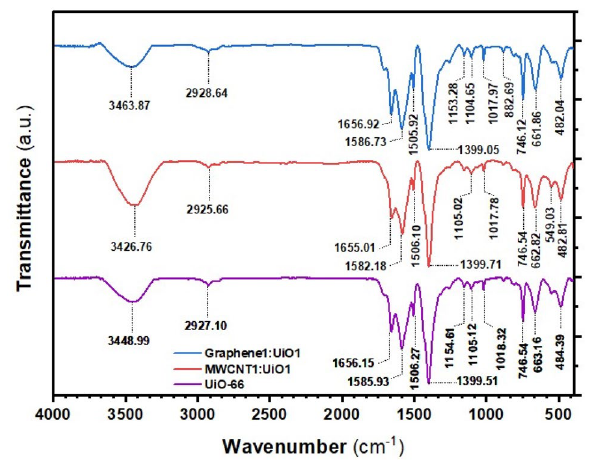
Figure 1. FTIR spectra of UiO-66, MWCNT1:UiO1 and Graphene1:UiO1.